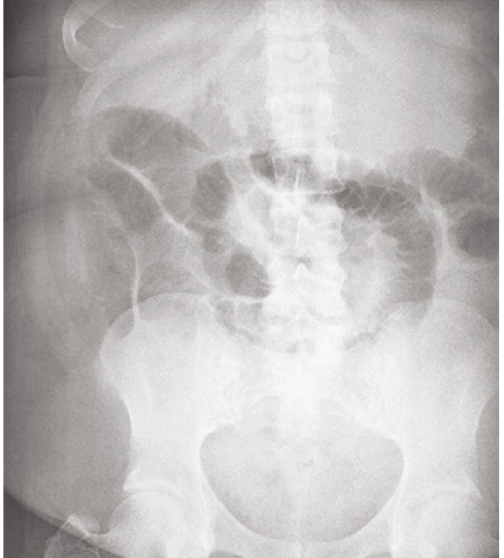
Figure 1: AP supine X-ray of the abdomen showing moderate gaseous distention of the small